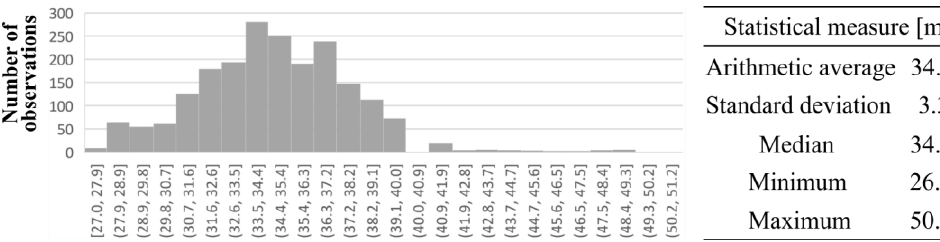
Figure 15. The error of height determination by the satellite compass m H [m].